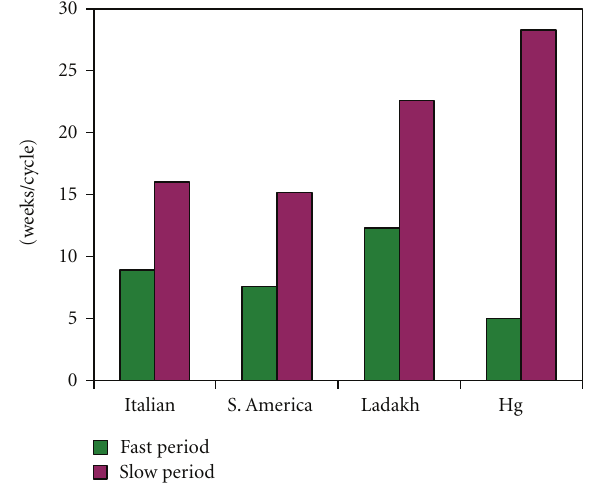
Figure 5: Fast and slow periods of hair growth in weekly cycles. The hairs from Huancavelica (Hg) show a shorter fast period and very prolonged slow period which correspond to the rest phase of hair